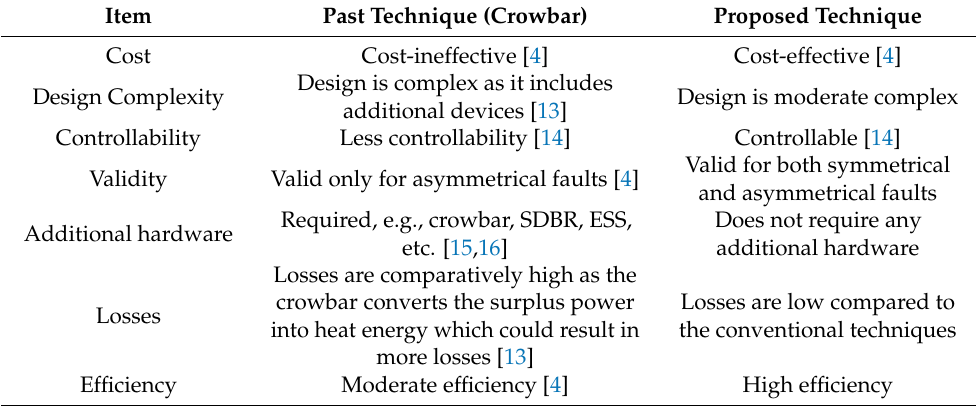
Table 1. Comparison between past and proposed techniques.